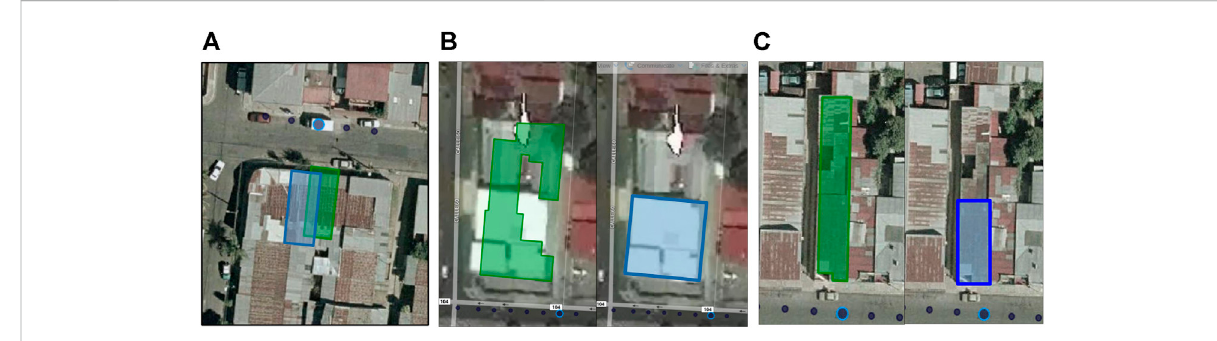
FIGURE 10 Dif fi culties with polygons highlighting building footprints. The color green denotes the polygon with error and the color blue denotes the corrected polygon. (A) corresponds to a position error, (B) to a geometry error, and (C) to a size error.